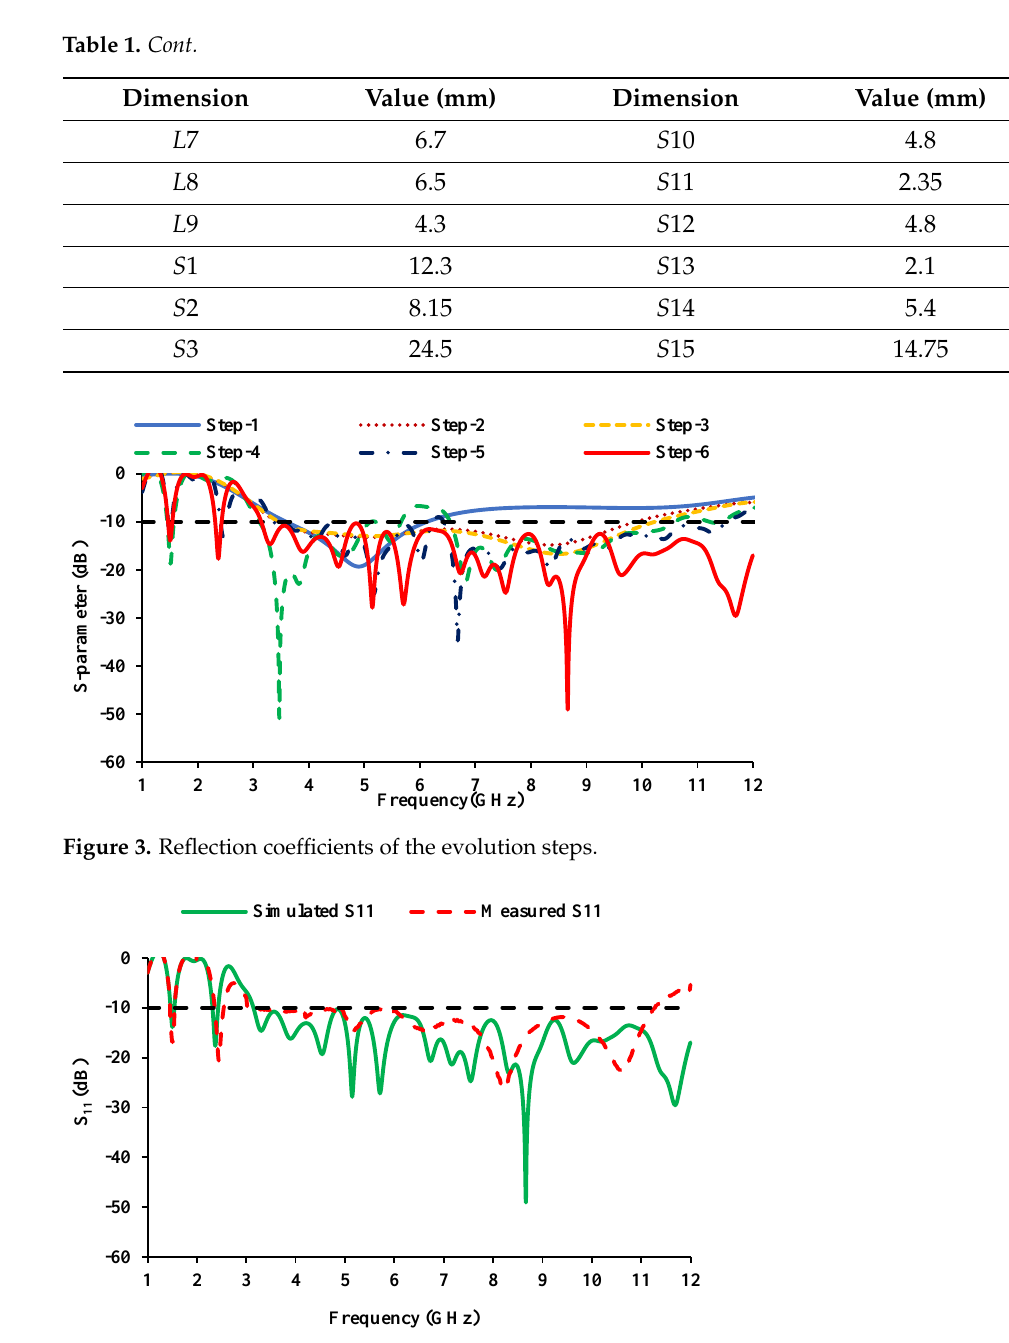
Figure 4. Reflection coefficients of the proposed antenna element.